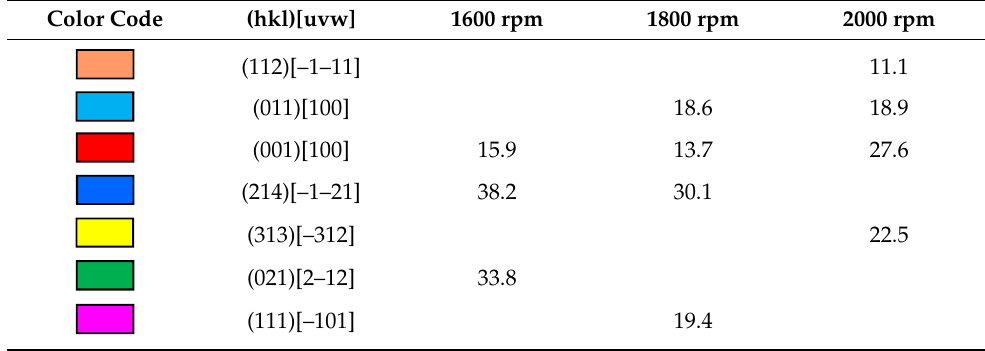
Table 2. Texture types and components of the weld nugget zone at different plug rotating speeds.